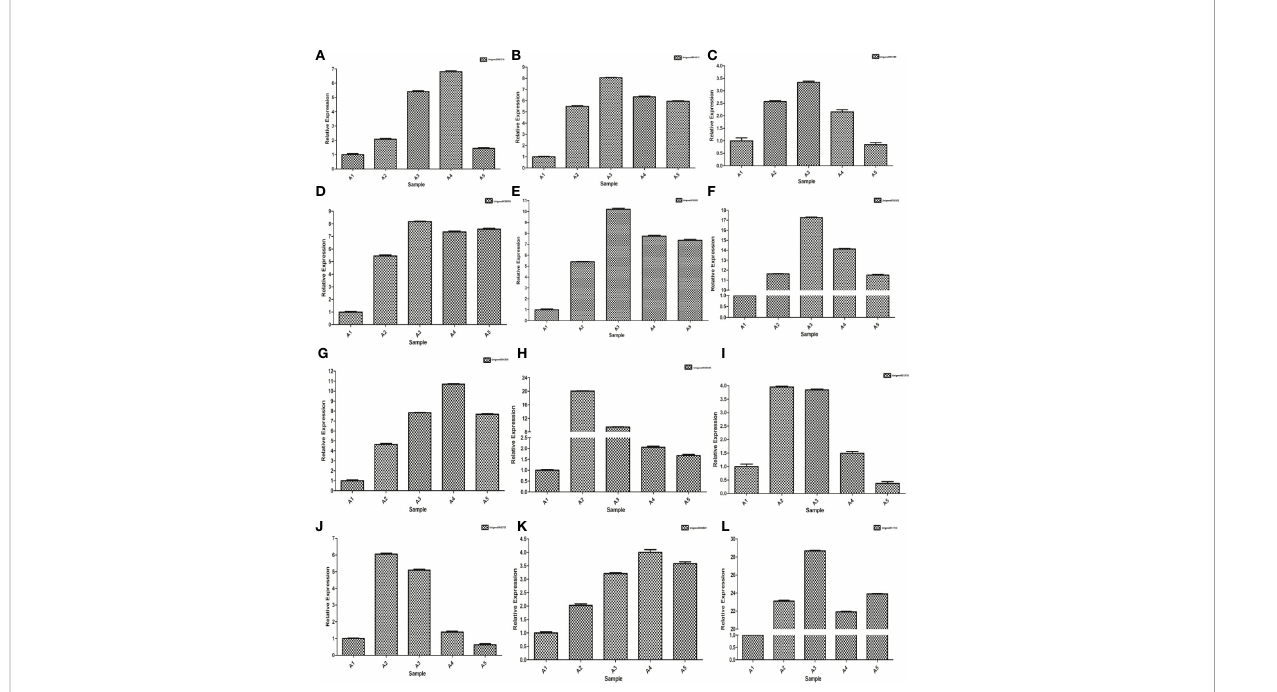
FIGURE 13 qRT-PCR expression validations of 12 genes. (A) Unigene0000718, (B) Unigene0004575, (C) Unigene0004788, (D) Unigene0011154, (E)